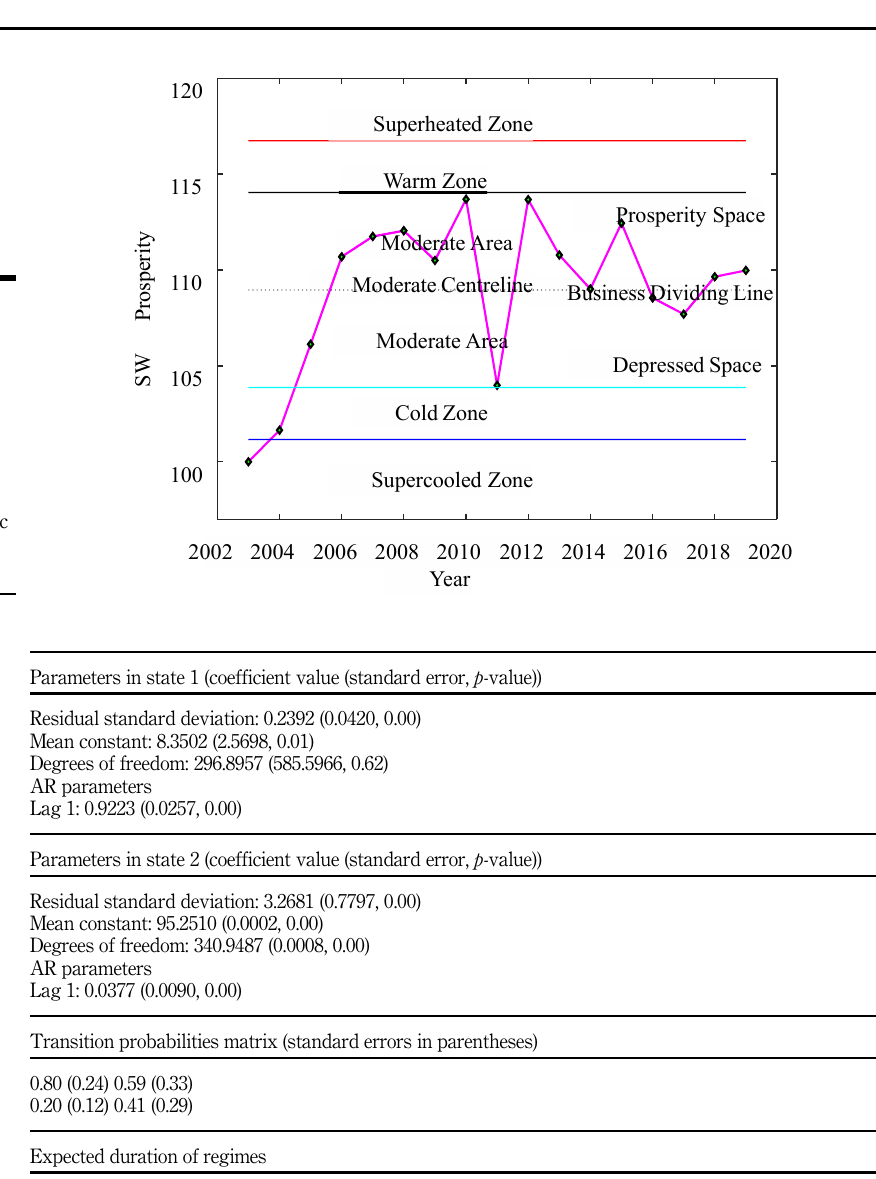
parameters of the Markovian state transition model for China ’ s marine